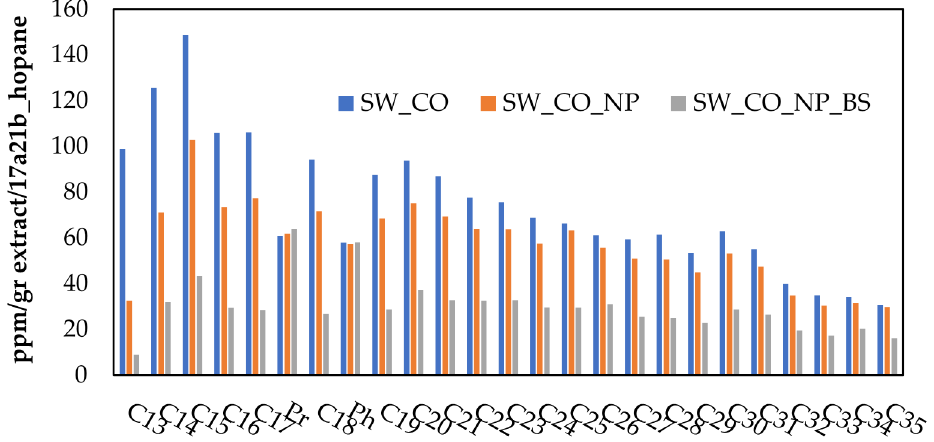
Figure 5. Bioremediation test results. Saturated hydrocarbons concentration after 28 days of bioremediation (Cx are the saturated hydrocarbons, x is the number of carbons in the molecule, Pr: pristane and Ph: phytane). (a) SW_CO: Sea water with crude oil. (b) SW_CO_NP: Sea water, crude oil and N and P nutrients. (c) SW_CO_NP_BS: Sea water, crude oil, N and P nutrients and BS-in-dH 2 O 0.4% w/v.